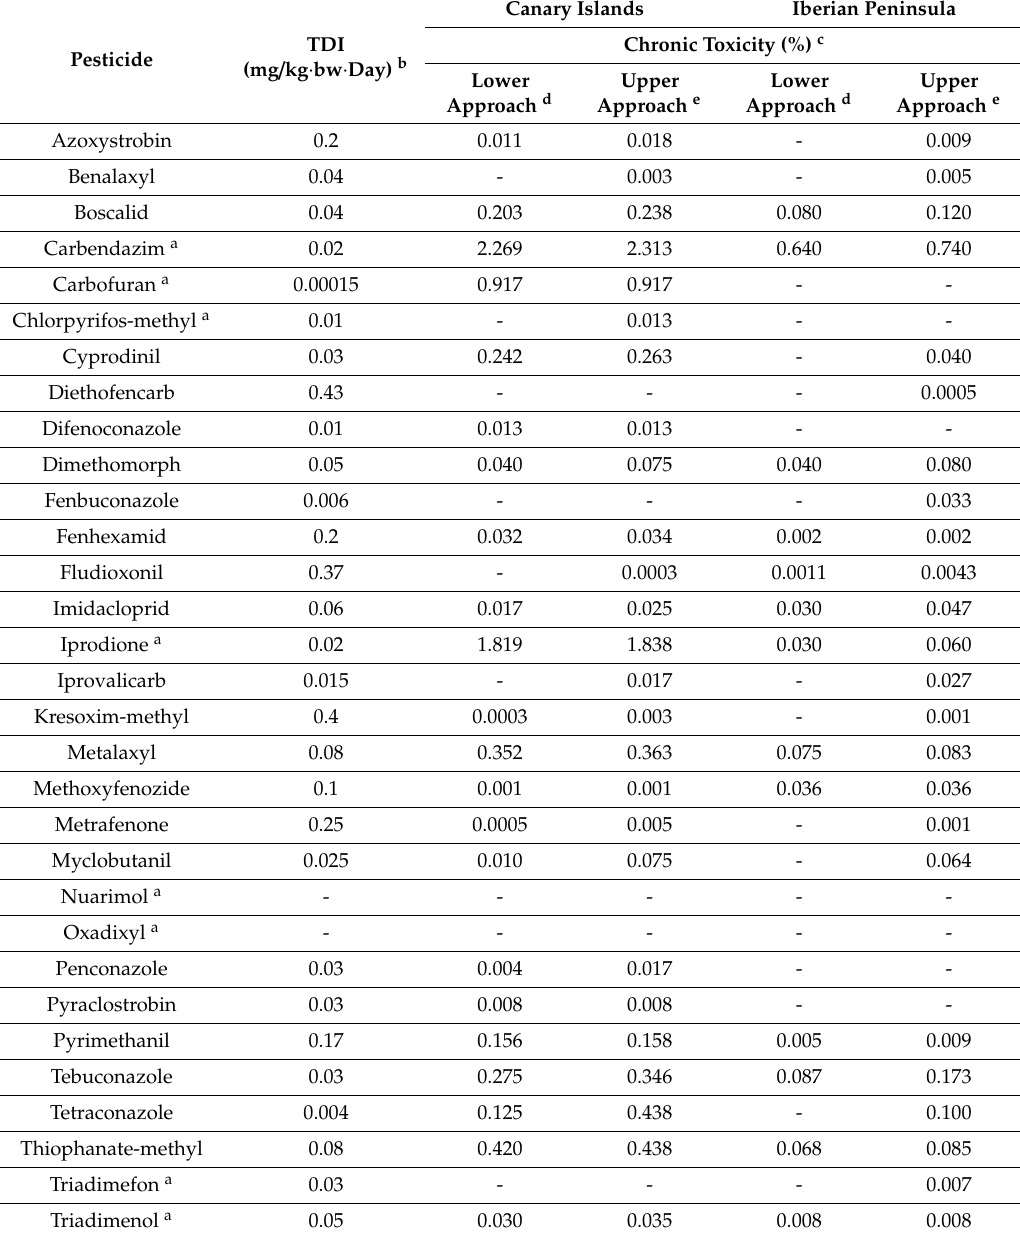
Table 3. Long-term toxicity study of detected pesticides in the analysed red wine samples ( n = 84).